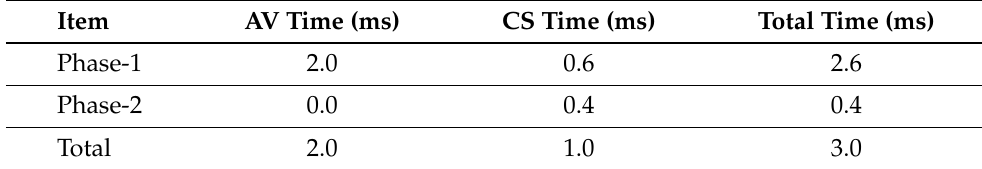
Table 6. Computational time for both AV and CS.